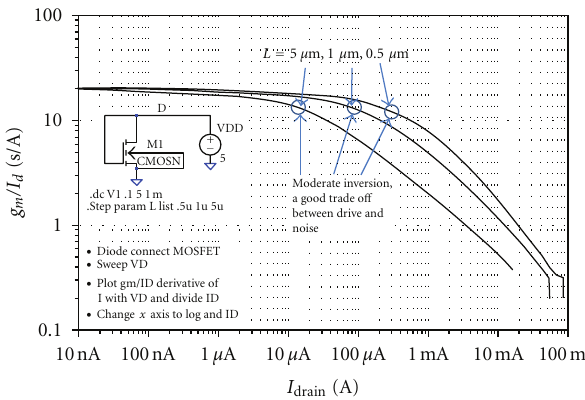
Figure 7: Determination of the DC gate bias as a function of the moderate inversion transition. The blue line is the transconduc- tance e ffi ciency curve (left axis), and the black line is the drain (gate) voltage (right axis). Each of these are stepped a − 0.250 V, 0V and +0.250 V, voltage o ff set values. The selection of the knee in the transconductance e ffi ciency curve leads to the selection of a 2 μ A I d . The point at which this intersects the gate voltage to provide the DC gate voltage bias point. This pair of values is used to design the single-stage amplifier